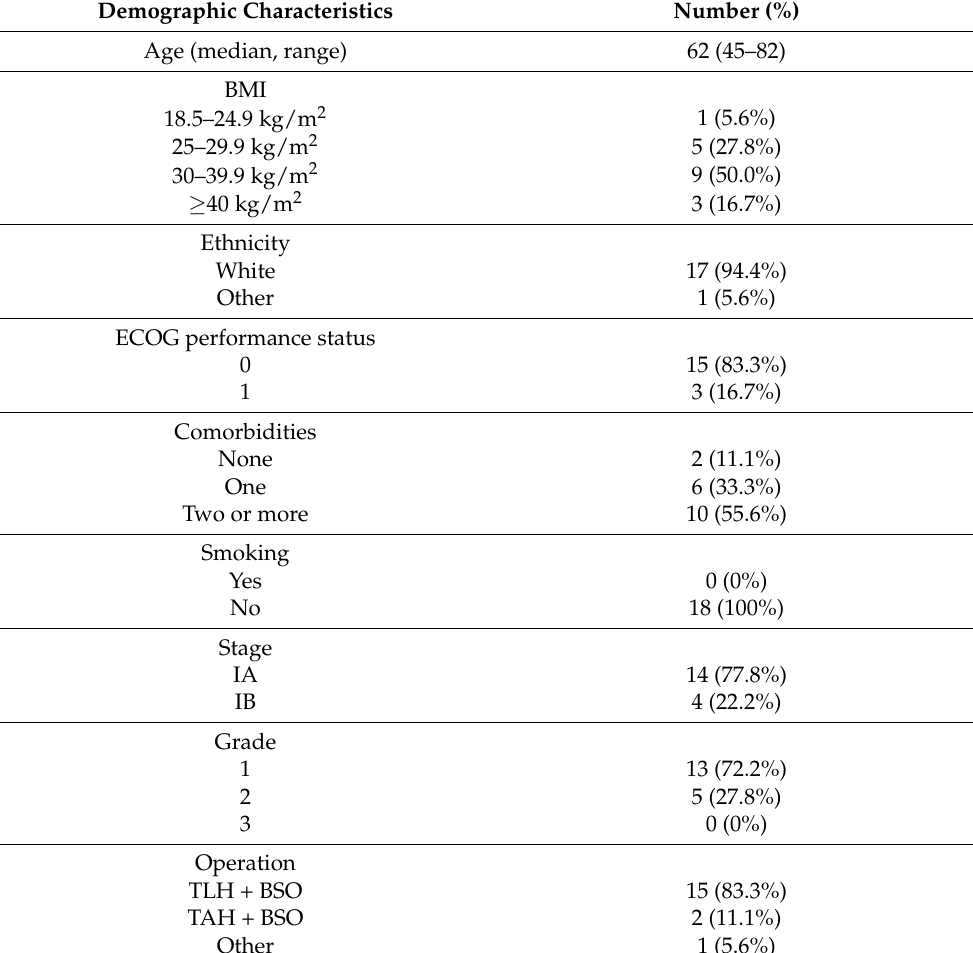
Table 2. Characteristics of the study